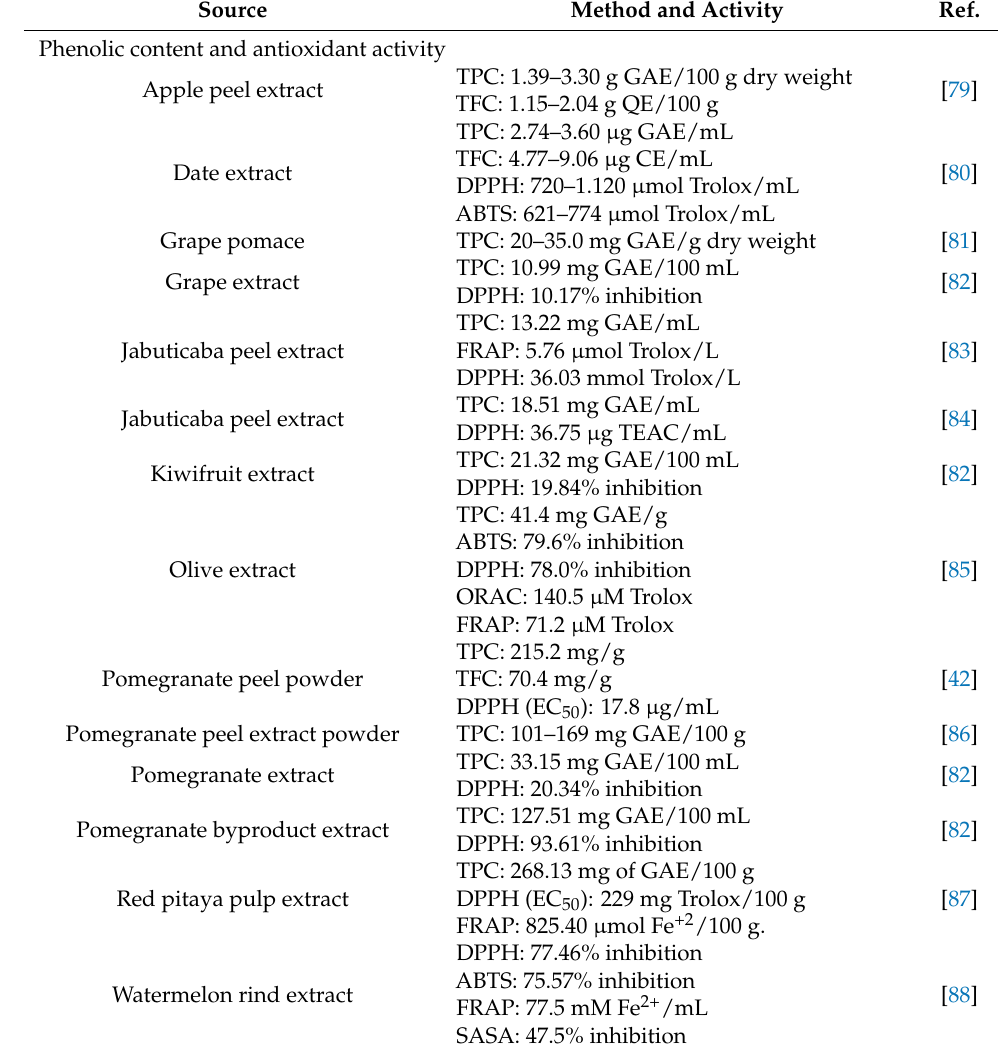
Table 3. In vitro evaluation of total phenolic content and antioxidant and antimicrobial activities. Source Method and